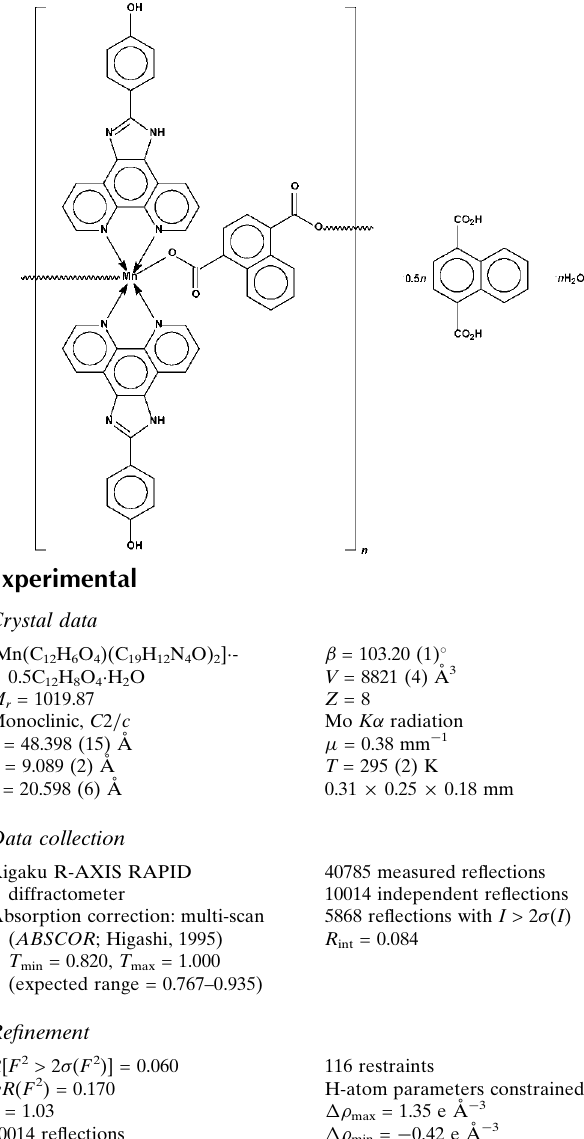
Rigaku R-AXIS RAPID diffractometer